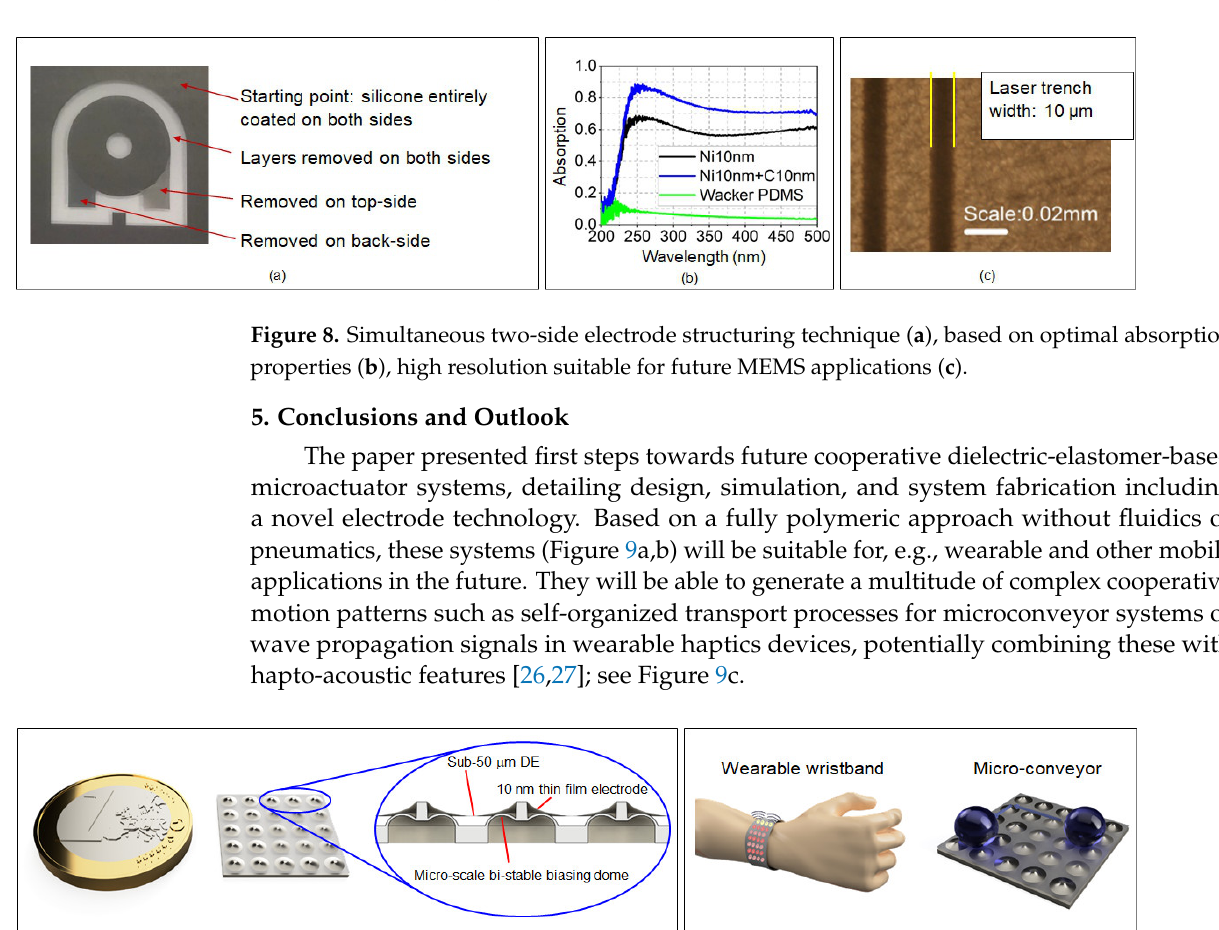
Figure 7. Single element DEA with Ni-sputtered nano-scale electrode ( a ), strong adhesion between electrode and silicone membrane ( b ), low resistance over large strain range ( c ), high cycle fatigue with stable resistance behavior ( d ).